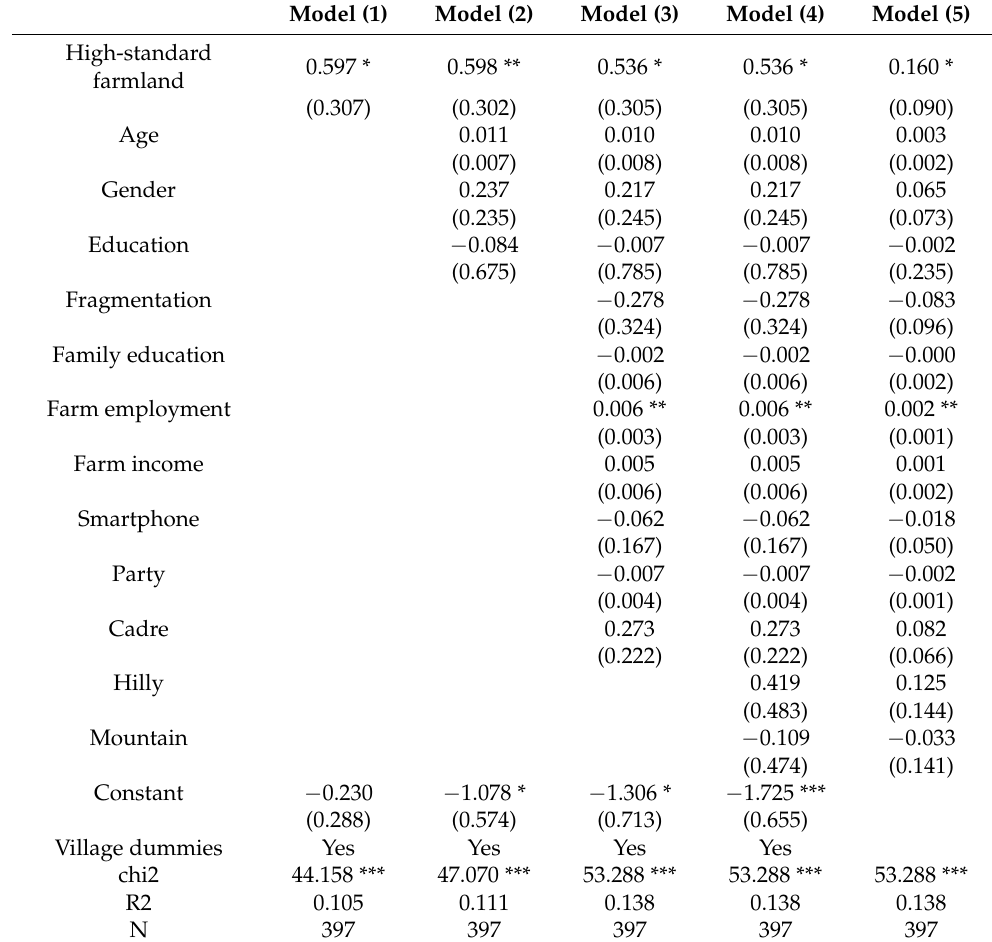
Table 2. Probit regression results of CHSF for